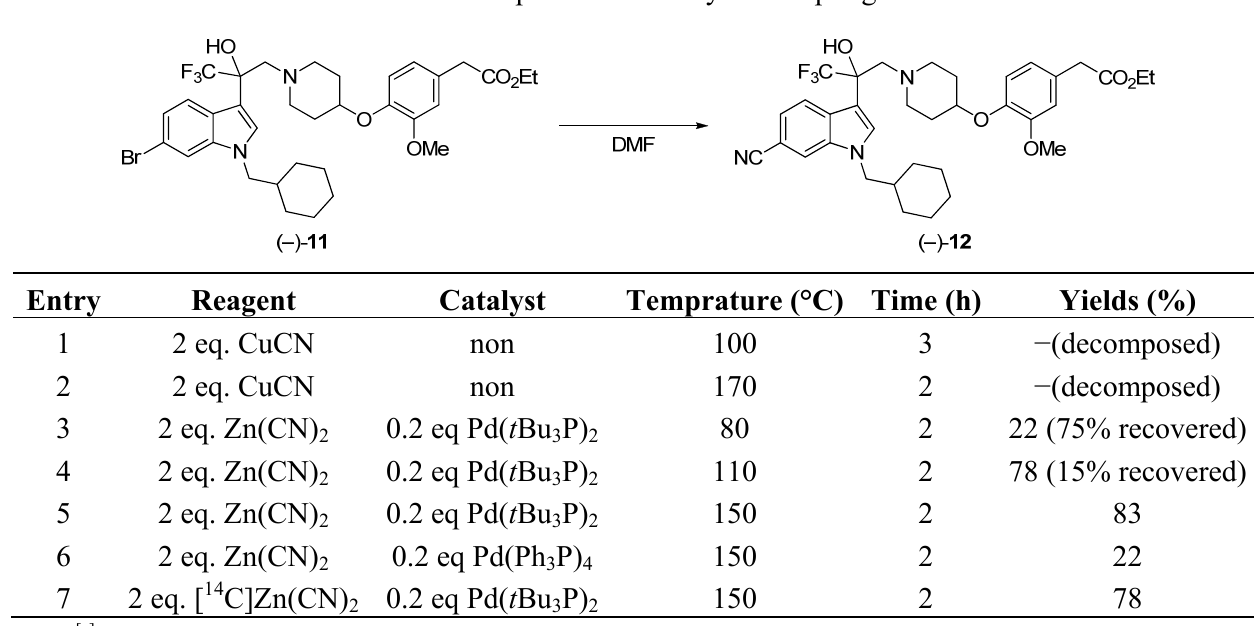
Table 3. Optimization of cyano coupling [ a ]